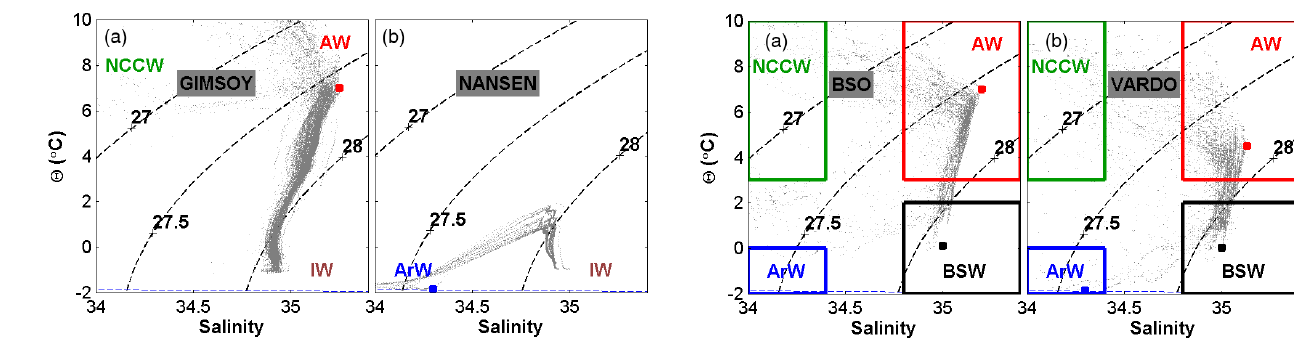
Figure 3. Potential temperature – salinity diagrams in August– September for the 1980–1985 period. (a) Gimsoy section (b) Nansen Basin. Red dot: ideal Atlantic Water; blue dot: ideal Arc- tic Water. Intermediate Arctic Waters: IW.